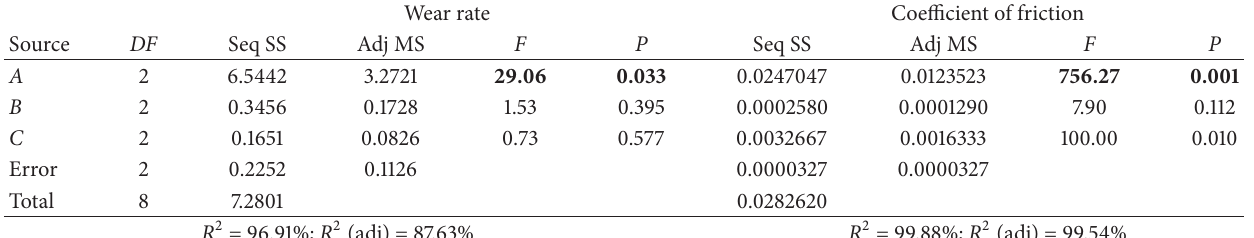
Table 10: Analysis of variance for wear rate of Al6061/12 wt.% Al 2 O 3 /MoS 2 .